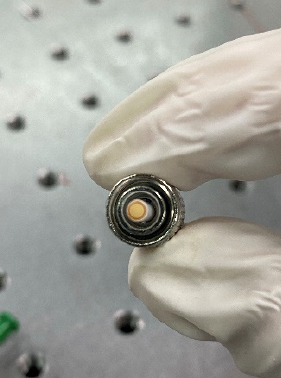
Figure 2. Fe 3 O 4 nanosheets are deposited on the end face of a fiber patch cord.